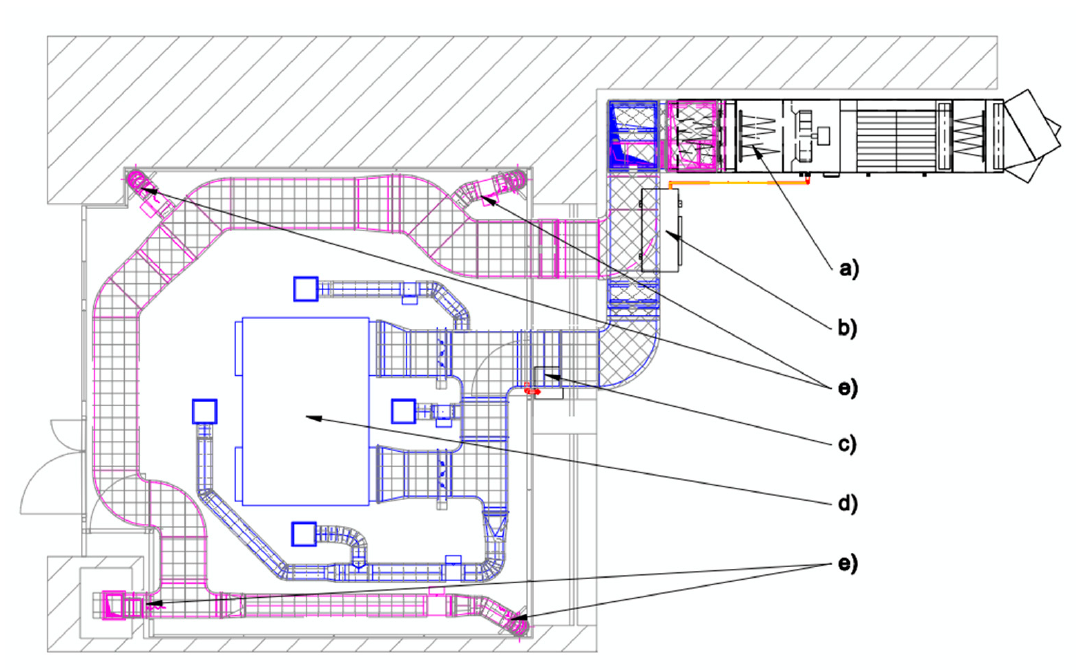
Figure 5. HVAC floor plan drawing: (a) ventilation unit, (b) heat pump, (c) air humidifier, (d) LAFC, Figure 5. HVAC fl oor plan drawing: (a) ventilation unit, (b) heat pump, (c) air humidi fi er, (d) LAFC, and (e) drainage outlets. and (e) drainage outlets.